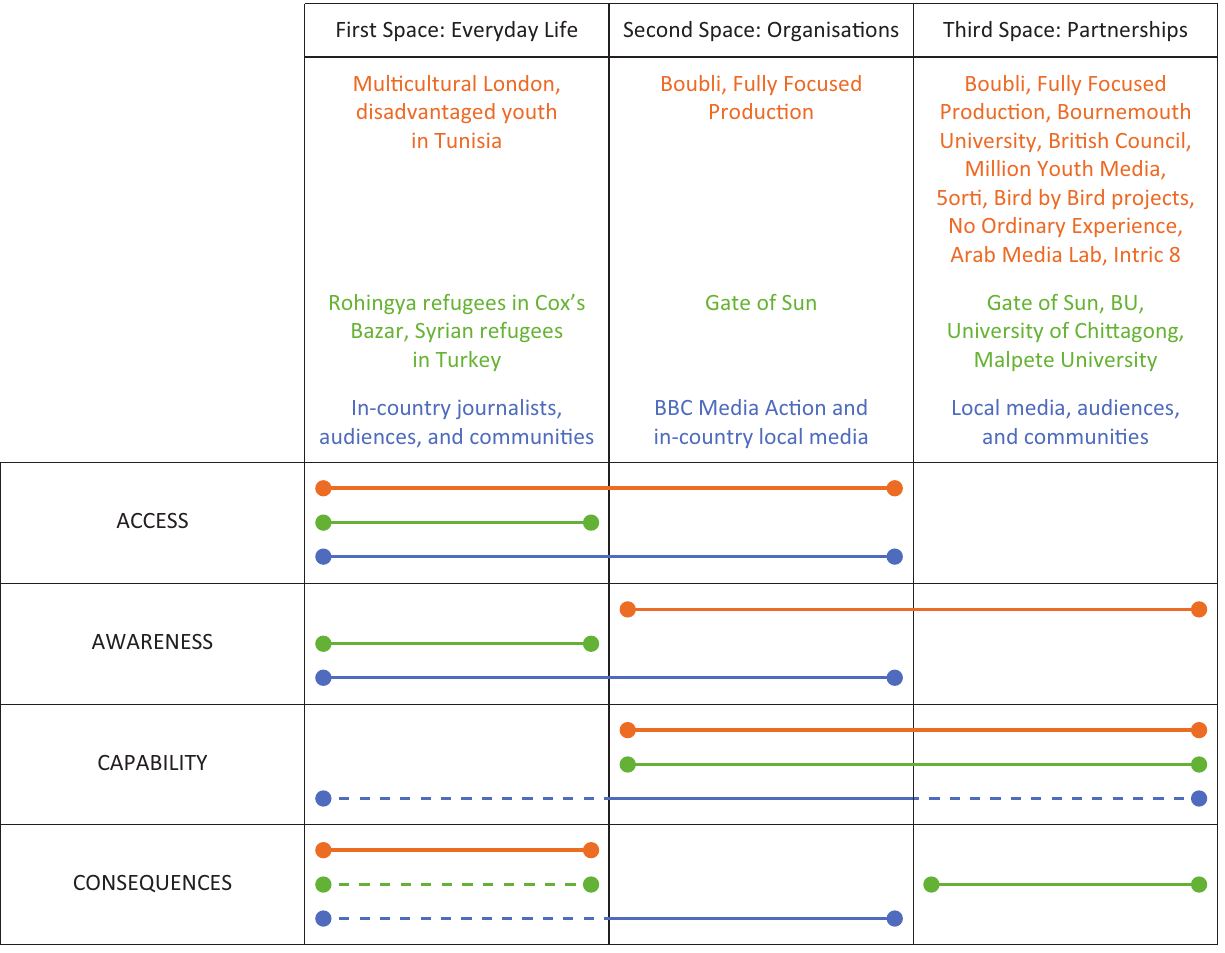
Table 1. A matrix mapping the intersection between spaces and the theory of